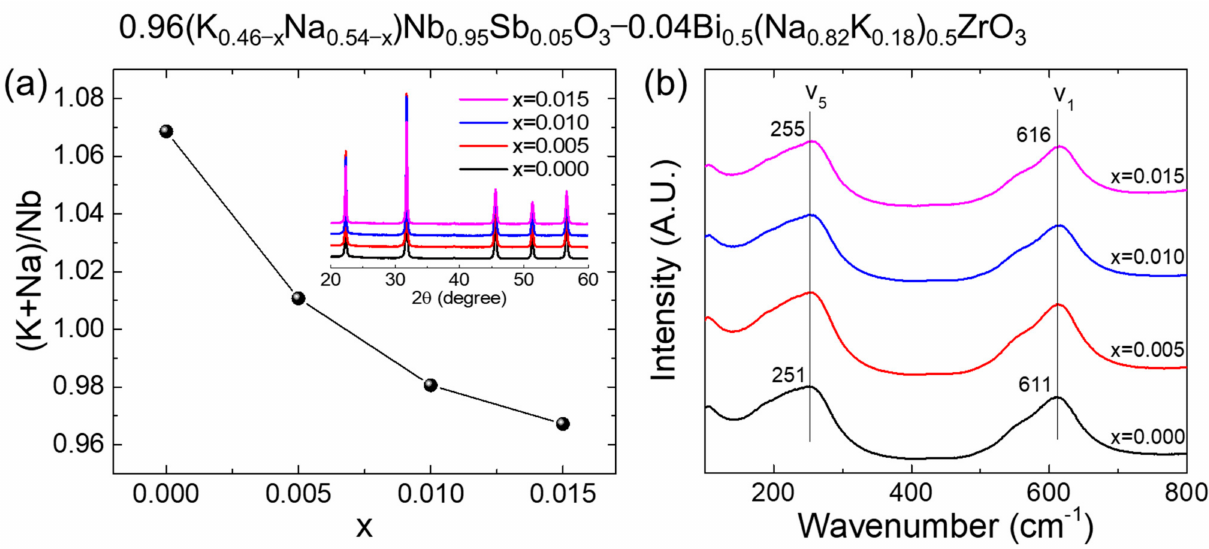
Figure 1. ( a ) Ratio of alkali-ion content to niobium ion content of 0.96(K 0.46 − x Na 0.54 − x )Nb 0.95 Sb 0.05 O 3 - 0.04Bi 0.5 (Na 0.82 K 0.18 ) 0.5 ZrO 3 calcined powders obtained by EDS analysis. Inset shows their XRD patterns. ( b ) Raman spectra of 0.96(K 0.46 − x Na 0.54 − x )Nb 0.95 Sb 0.05 O 3 -0.04Bi 0.5 (Na 0.82 K 0.18 ) 0.5 ZrO 3 calcined